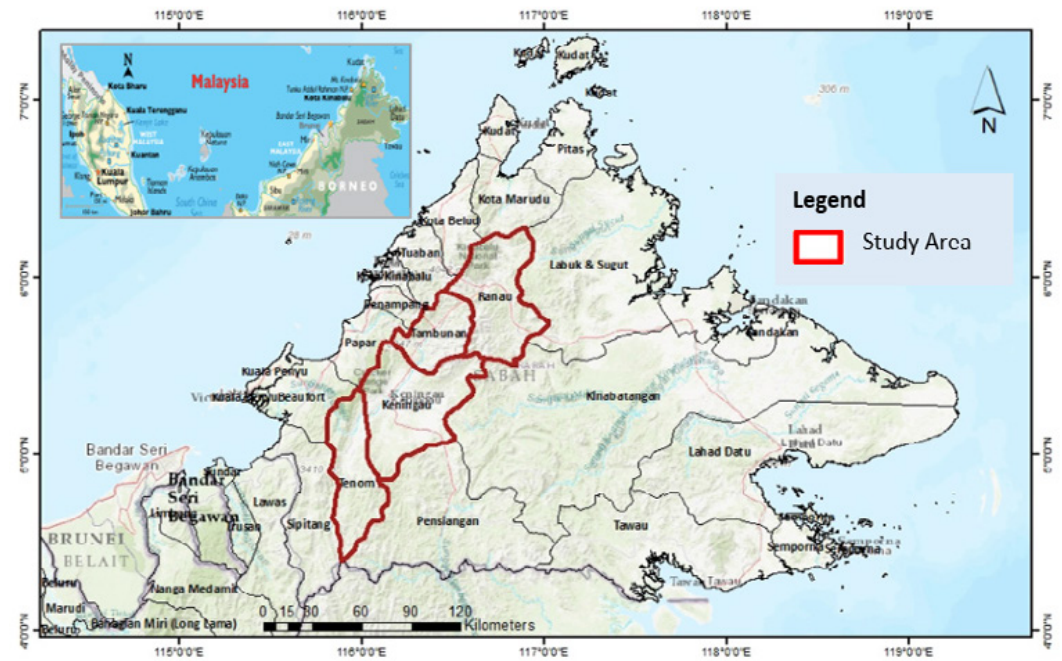
Fig. 1: Geographic location of the study area in selected districts of Sabah, Malaysia with a red line indicated the boundary of each district which the study was conducted